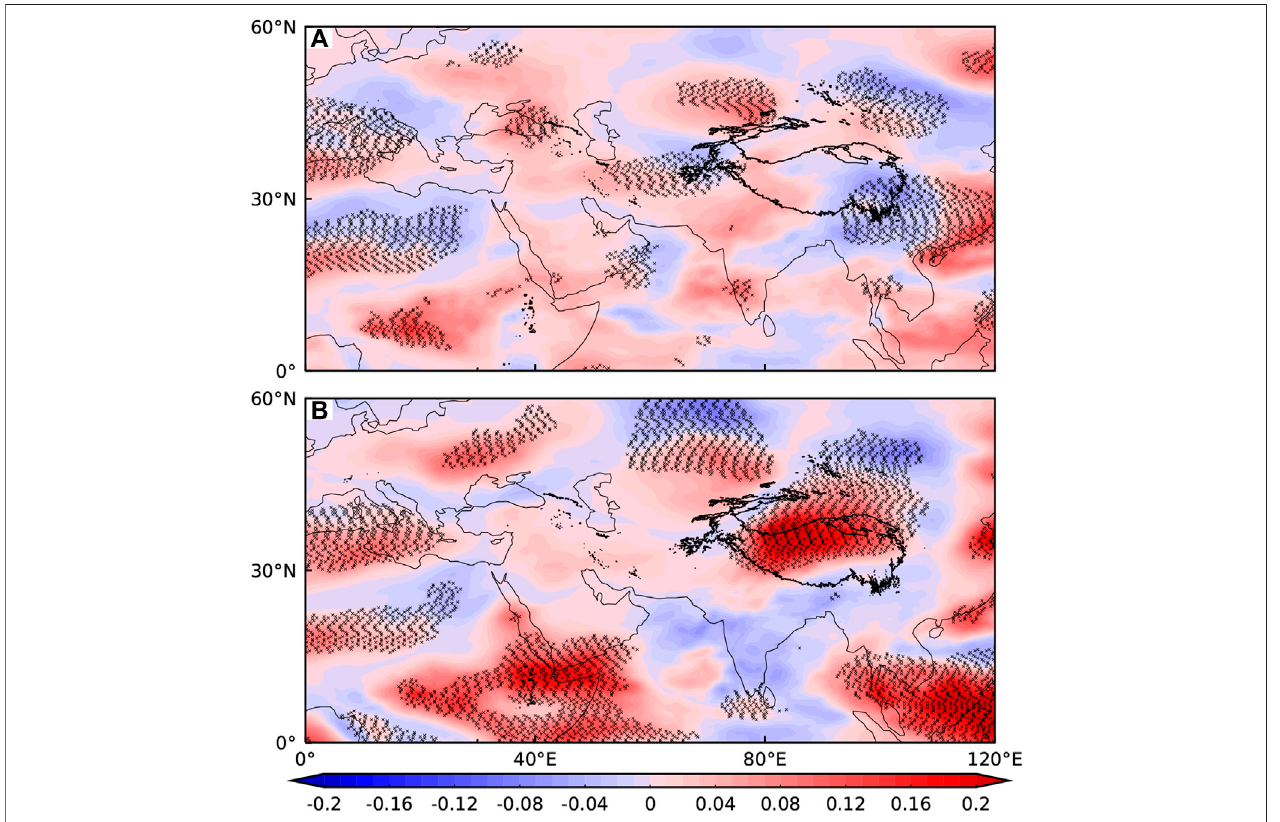
FIGURE9| Information fl owbetween thewestern ridgepoint index (WRPI) fortheWPSH and TCO*(shading). Blackdotsrepresentsigni fi cantinformation fl owsat the 90% con fi dence level; (A) T 1 → 2 : WRPI → TCO p and (B) T 2 → 1 : TCO p → WRPI .